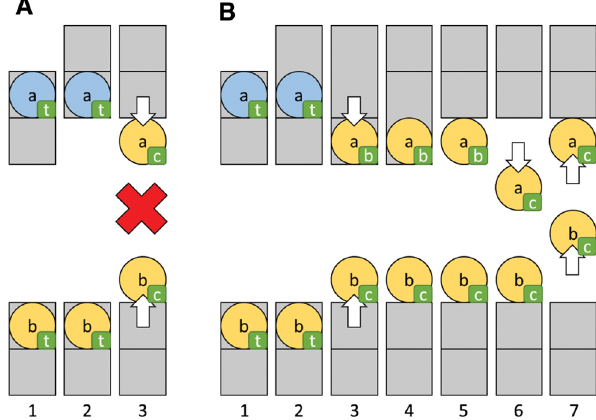
Figure 4: (A) Incorrect and (B) correct parallel seam adjustment. The small letters in rectangles indicate the current list the cells belong to (t = top seam part, b = bottom seam part, c =